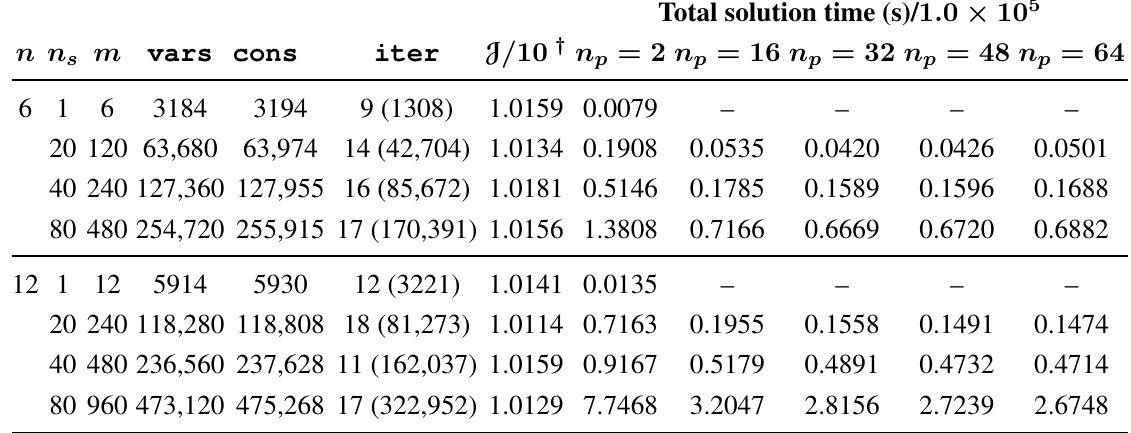
Table 3. Case Study 2: parallel computation results comparing increasing n and n